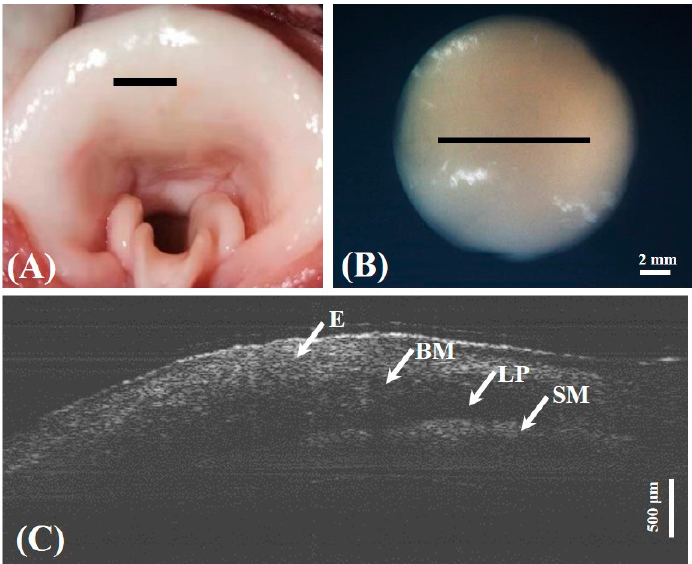
Figure 4. Ex vivo porcine larynx experiment. ( A ) Picture of the ex vivo porcine larynx; ( B ) white light laryngoscope image; ( C ) OCT image of the black line region. E: epithelial layer; LP: mucosa lamina propria; SM: smooth muscle layer; BM: basement membrane.